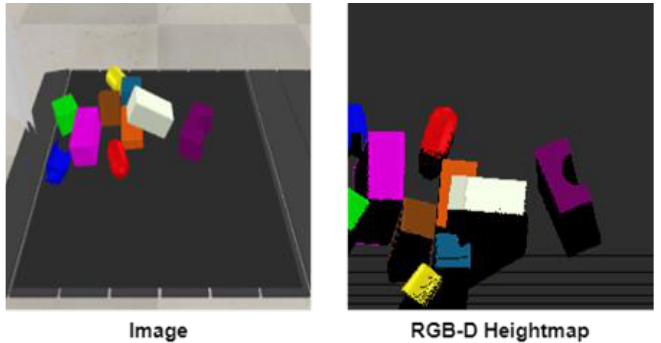
Figure 3. A sample of current view image from the workspace at timestep t and its generated RGB-D 224 × 224 pixel heightmap representation of the state s t .